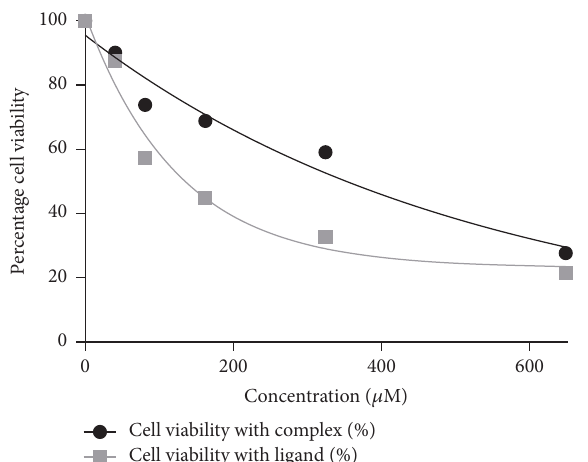
Figure 5: The plot of percentage cell viability versus concentration of the test compounds ( 𝜇 M) obtained by Sulforhodamine B assay.